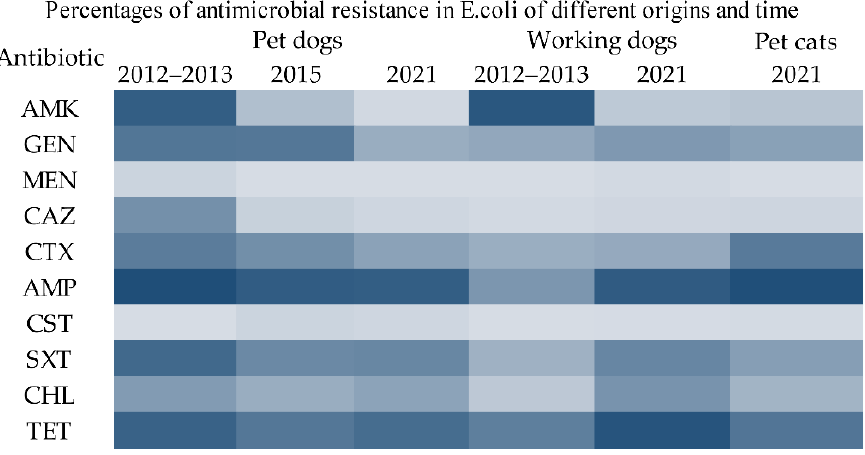
Figure 2. Trends of resistance to various antibiotics of 554 E. coli isolates from different origins be ‐ tween 2012–2021 (the depth of color of the rectangle represents the degree of resistance of the iso ‐ lates to the antibiotic, and the darker the color, the stronger the drug resistance). AMK, amikacin; GEN, gentamicin; MEN, meropenem; CAZ, ceftazidime; AMP, ampicillin; CST, colistin; SXT, trime ‐ thoprim ‐ sulfamethoxazole; CHL, chloramphenicol; TET, tetracycline. Notes: the antibiotics listed in Figure 2 only include the antibiotics tested against all E. coli .